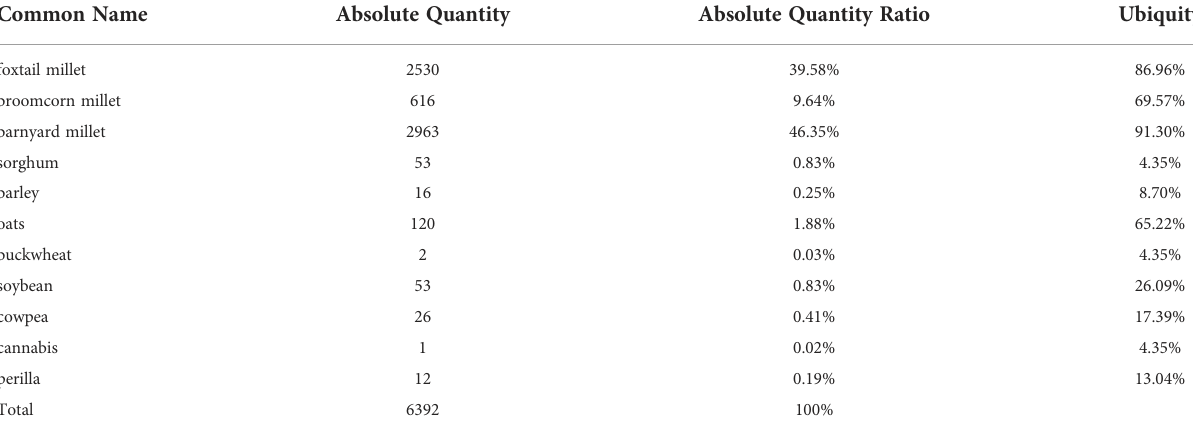
TABLE 3 The absolute number and ubiquity of agricultural crops at the LMC site.